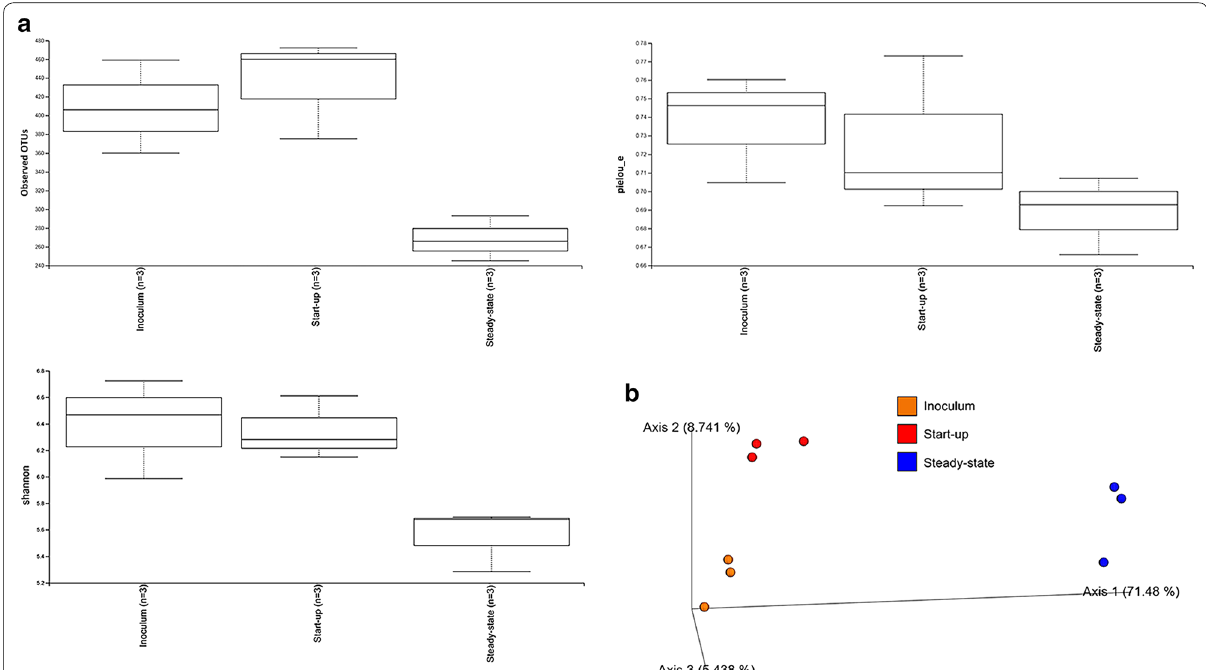
Fig. 1 α-diversity plots. a Observed OTUs, Shannon index and Pielou’s index. b Principle coordinate analysis of the OTU distribution in the inoculum (orange dots) and in the three reactor replicates, during the start-up phase (red dots) and during steady-state conditions (blue